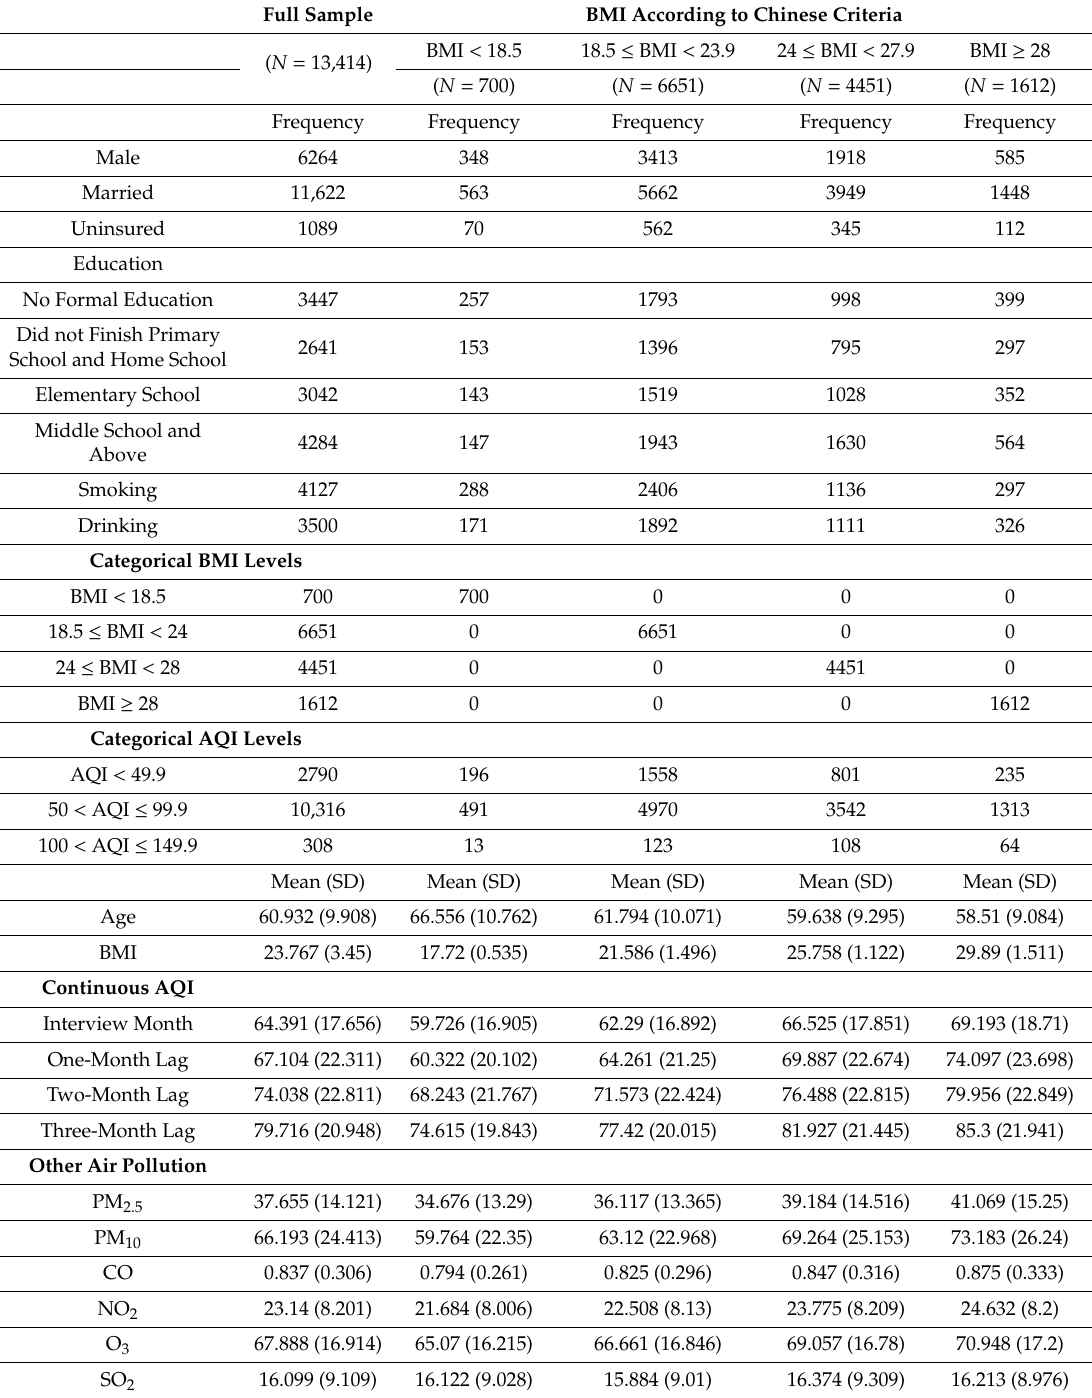
Table 2. Characteristics of the study